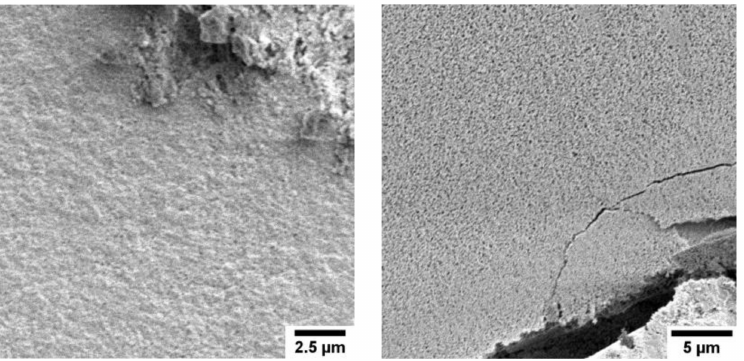
Figure A1. High magnification SEM images of samples mineralized at pH 8 using 5 mM NTA ( left ) and 10 mM NTA ( right ) as